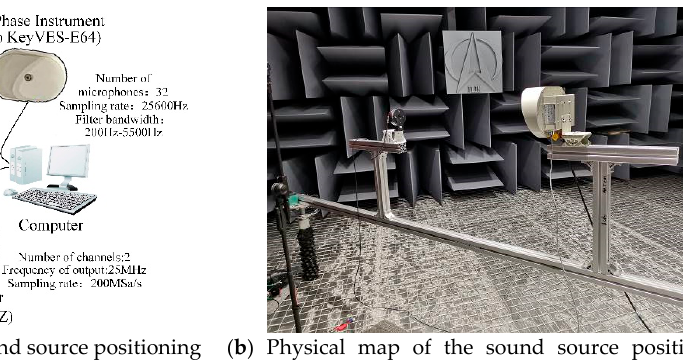
Figure 13. Sound source positioning experiment system.